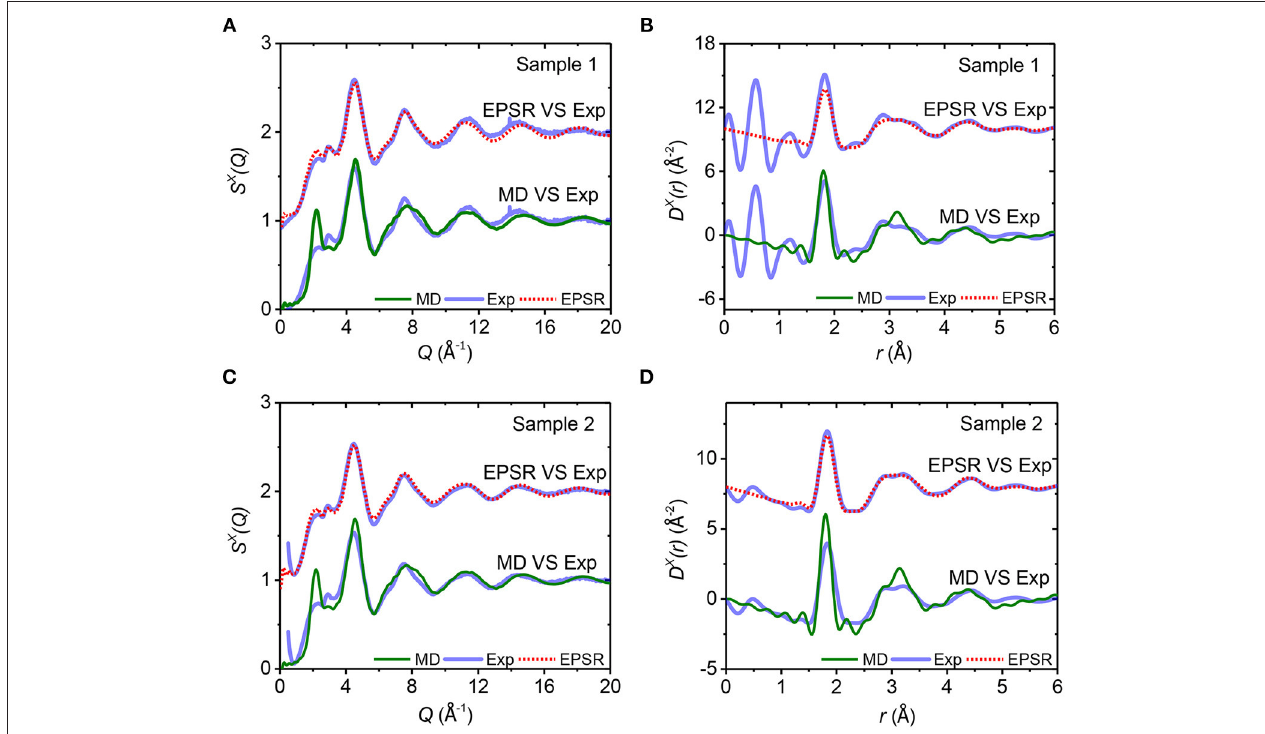
FIGURE 6 | The x-ray total structure factors S(Q) (A,C) and total distribution functions D(r) (B,D) for amorphous alumina, obtained with a Q max of 20.0 Å − 1 . In each panel, the measured data (solid blue lines) are compared to the EPSR (dotted red lines) and MD simulation results (solid green lines).